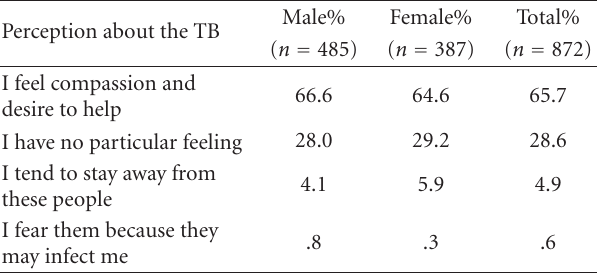
Figure 2: Knowledge about duration of TB treatment ( N = 872). Table 6: Feeling about other TB patients.